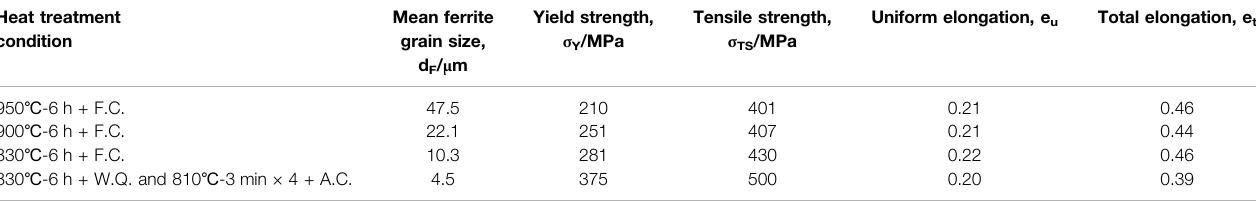
The lower yield strength after yield-drop was taken as the yield strength.